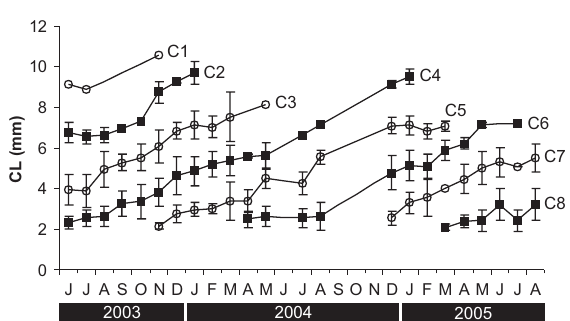
two axes of the canonical correspondence analysis (CCA) performed in order to evaluate distribution and abundance patterns accounted for 81.6% of the total variance (eigenvalues of 0.320 and 0.261, respectively) and 85.5% of the variance due to species abundance-environment relations. The ordi- nation diagram of the first 2 axes showed that the points found to the left of the diagram are strongly related to temperature. Females with a CL>7.7 mm (F) were associated with cold seasons while berried females with a CL<7.7 mm ( o ) and immature indi- viduals ( I ) were associated with warm seasons. Peak abundance of berried females was observed in